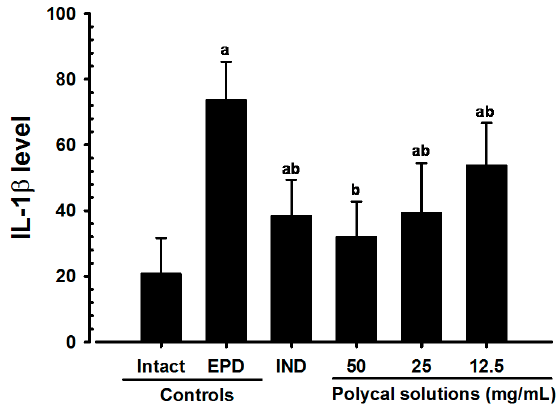
Figure 5. Gingival IL-1 β levels in Intact or EPD rats. Values are expressed mean ± S.D. of eight rats, pg/mL. EPD = experimental periodontal diseases induced by ligature placement around the cervix of upper left incisor teeth; Polycal = Polycan and calcium gluconate 2:98 (g/g) mixture, which was topically applied to ligated gingival regions, once a day for 10 days (200 μ L/rats); IND = Indomethacin, which was orally administered at 5 mg/kg dose level, once a day for 10 days. IL = Interleukin. a p < 0.01 as compared with Intact control; b p < 0.01 as compared with EPD control.